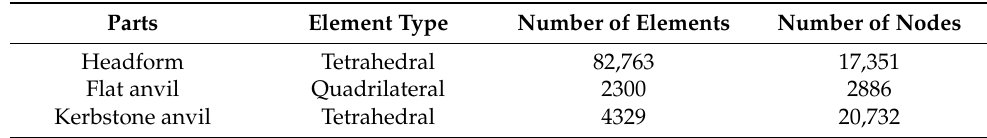
Table 2. Details of the finite element model of the headform and